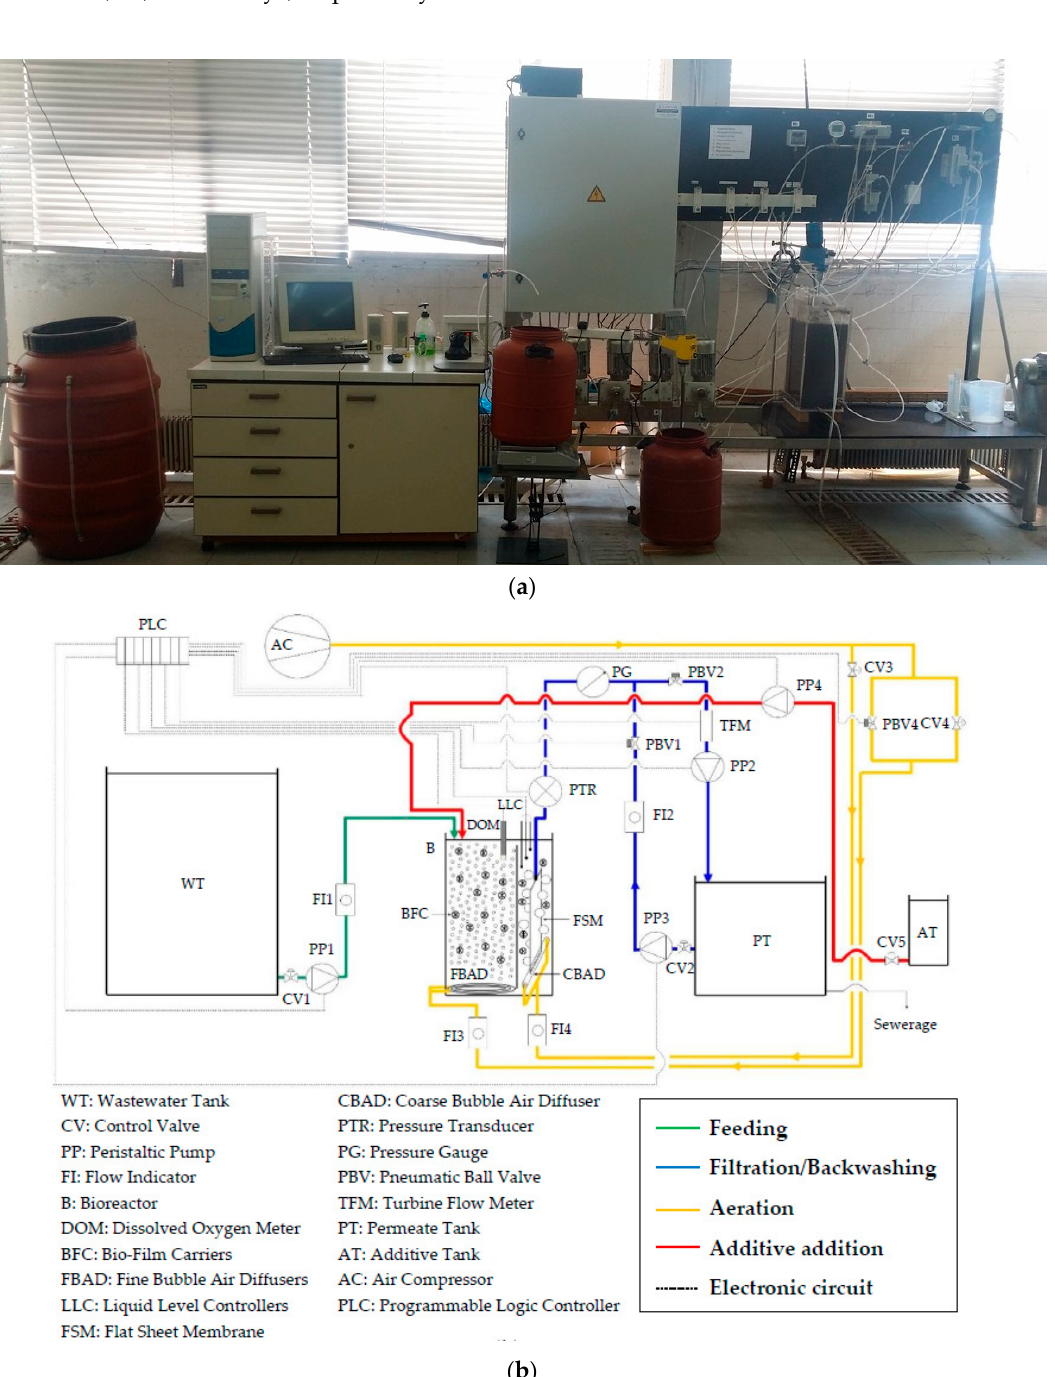
Figure 1. ( a ) Lab-scale membrane bio-reactor (MBR); ( b ) schematic of the lab-scale MBR.